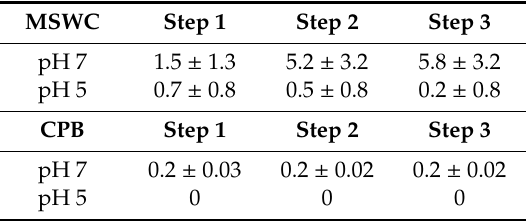
Table 4. Desorption percentages of previously adsorbed dye after contact with compost (mean ± standard deviation, n = 3). MSWC: municipal solid waste compost; CPB: composted pine